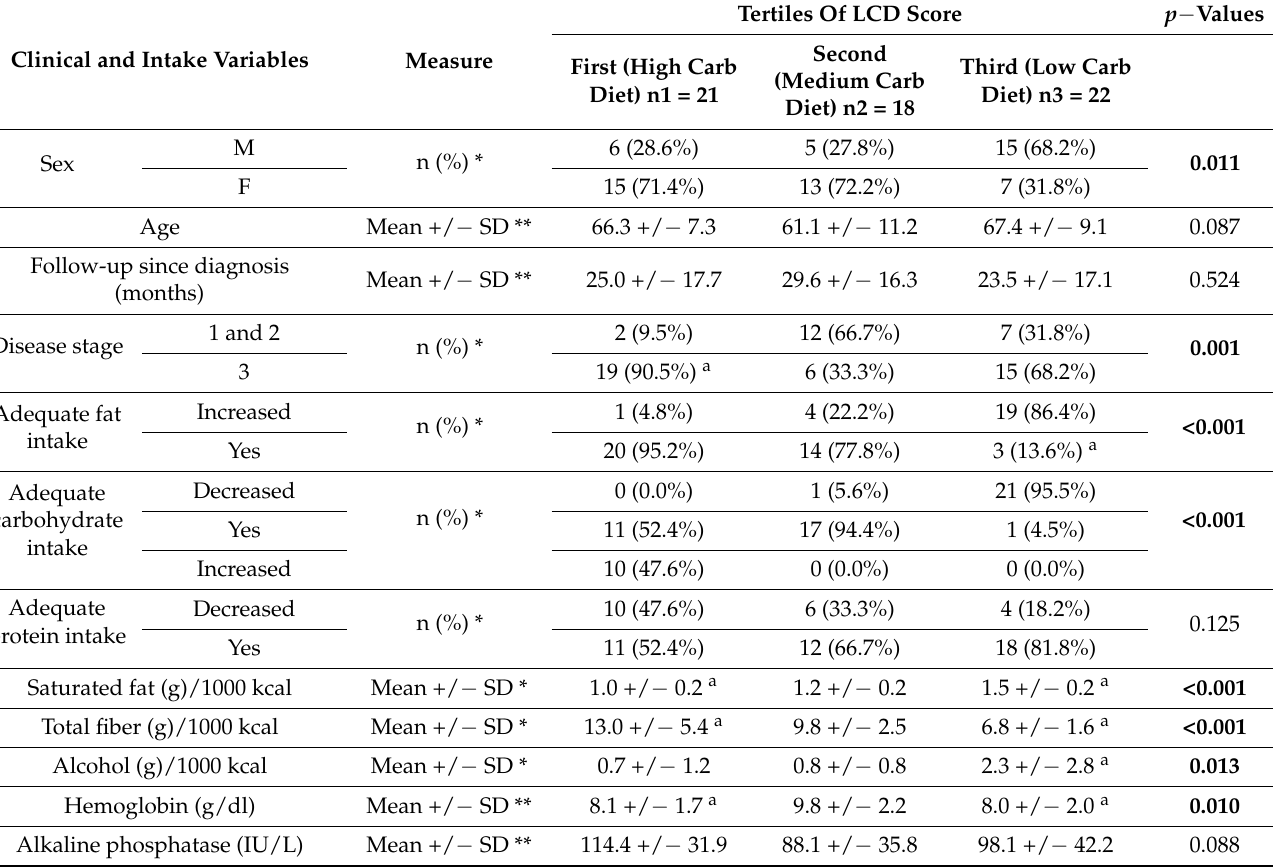
Table 3. Clinical and intake variables per tertile of LCD